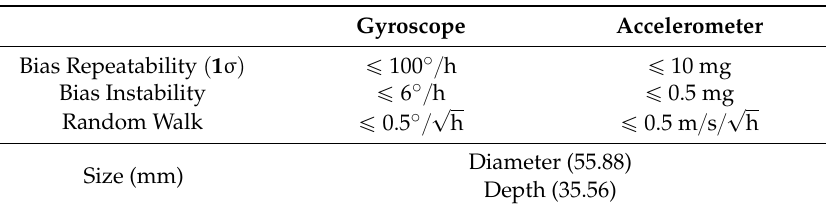
Table 1. MEMS-IMU